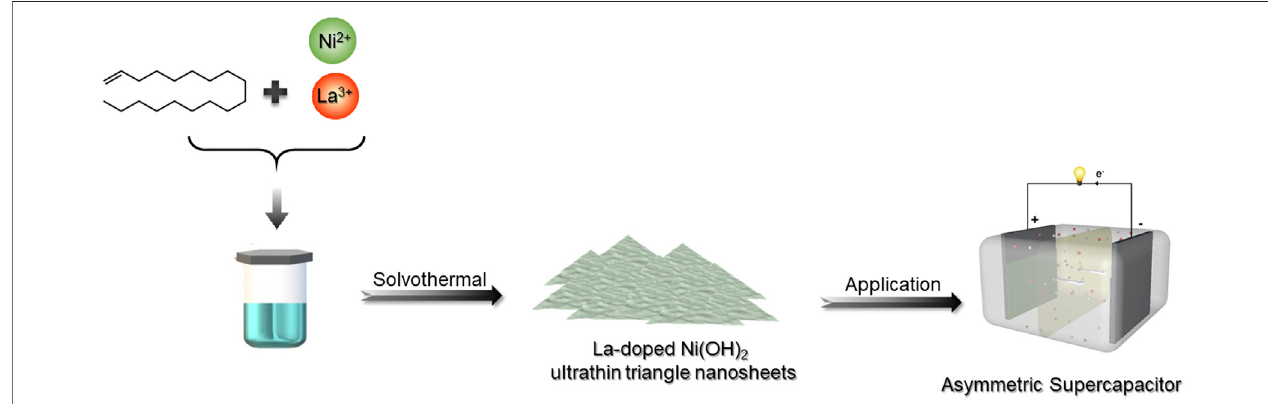
FIGURE 1 | A schematic illustration of the formation of LONH ultrathin triangle nanosheets.